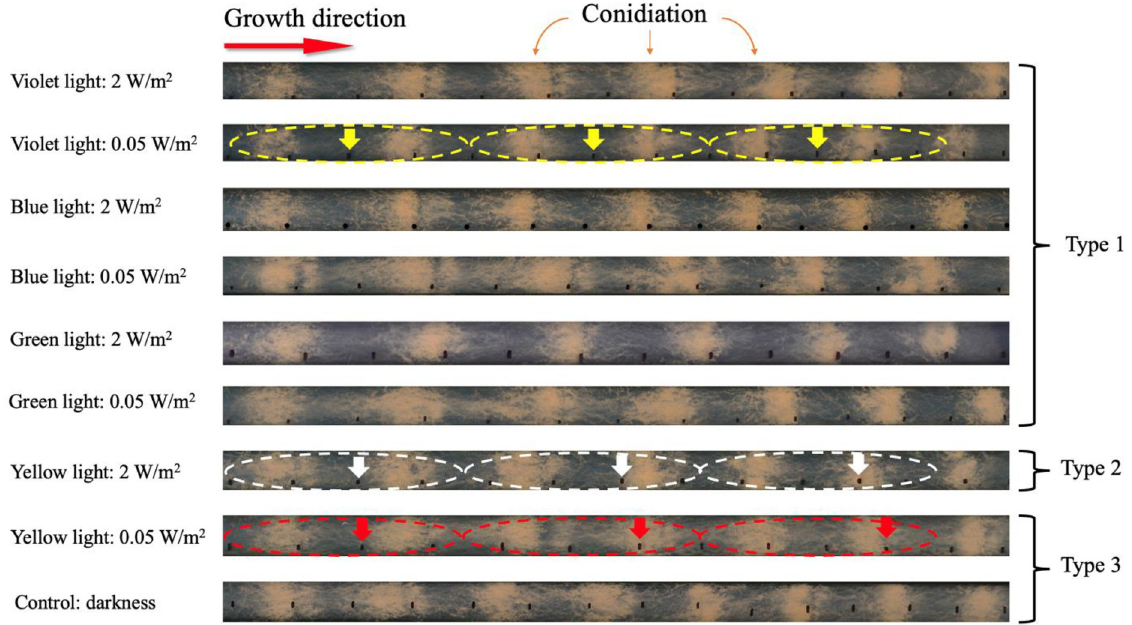
Fig 2. Growth results of the samples. The samples were placed on the starting points on the far-left side of the Race Tube. It grew up from the left side to the right side to the end of the Race Tube. The orange sections in the picture mark the conidiations. The black spots on the Race Tubes were the growth length of the sample, which were marked every 12 hours. There were three different types of growth results, and the arrows indicated a black spot at 24 hours, 72 hours and 120 hours. Type 1 (yellow arrows) showed that a 24 hours period of circadian rhythm, the three arrows were always in the middle of conidiation. Type 2 (white arrows) indicated that a 22.3 hours per period, the second arrow approached conidiation, and the third arrow was included in conidiation. Type 3 (red arrows) was around 21.7 hours per period, the second arrow was included in conidiation, the third arrow exceeded conidiation.